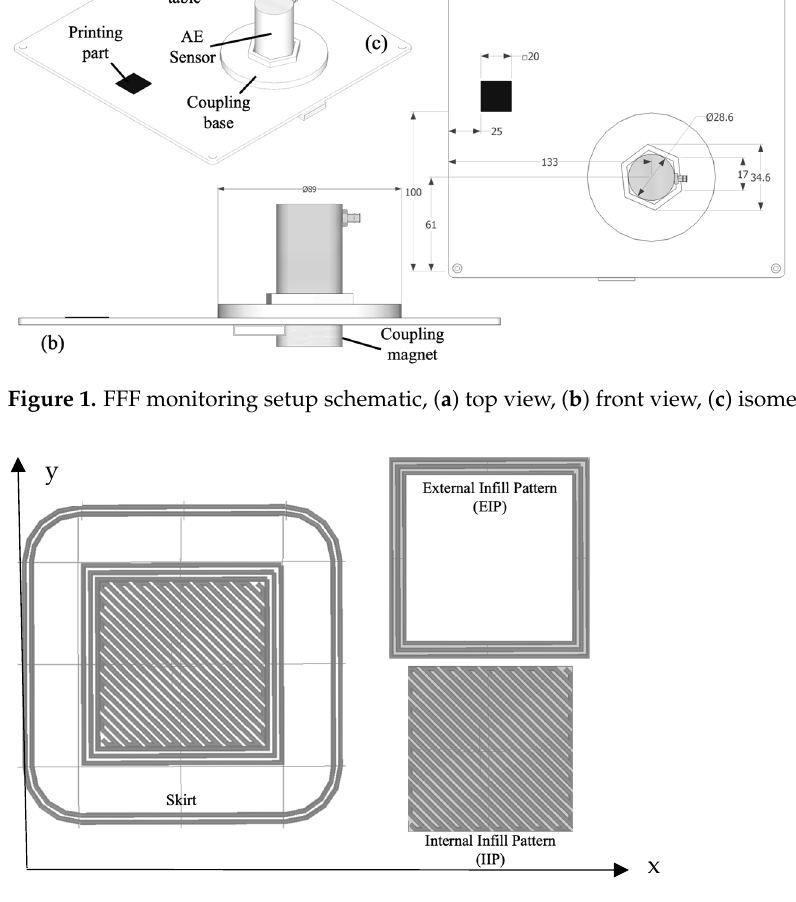
Figure 1. FFF monitoring setup schematic, ( a ) top view, ( b ) front view, ( c ) isometric view.